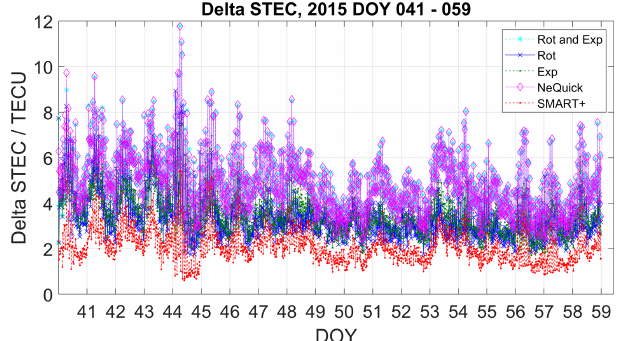
Figure 10. Plausibility check for the perturbed period. (cid:49) STEC val- ues versus